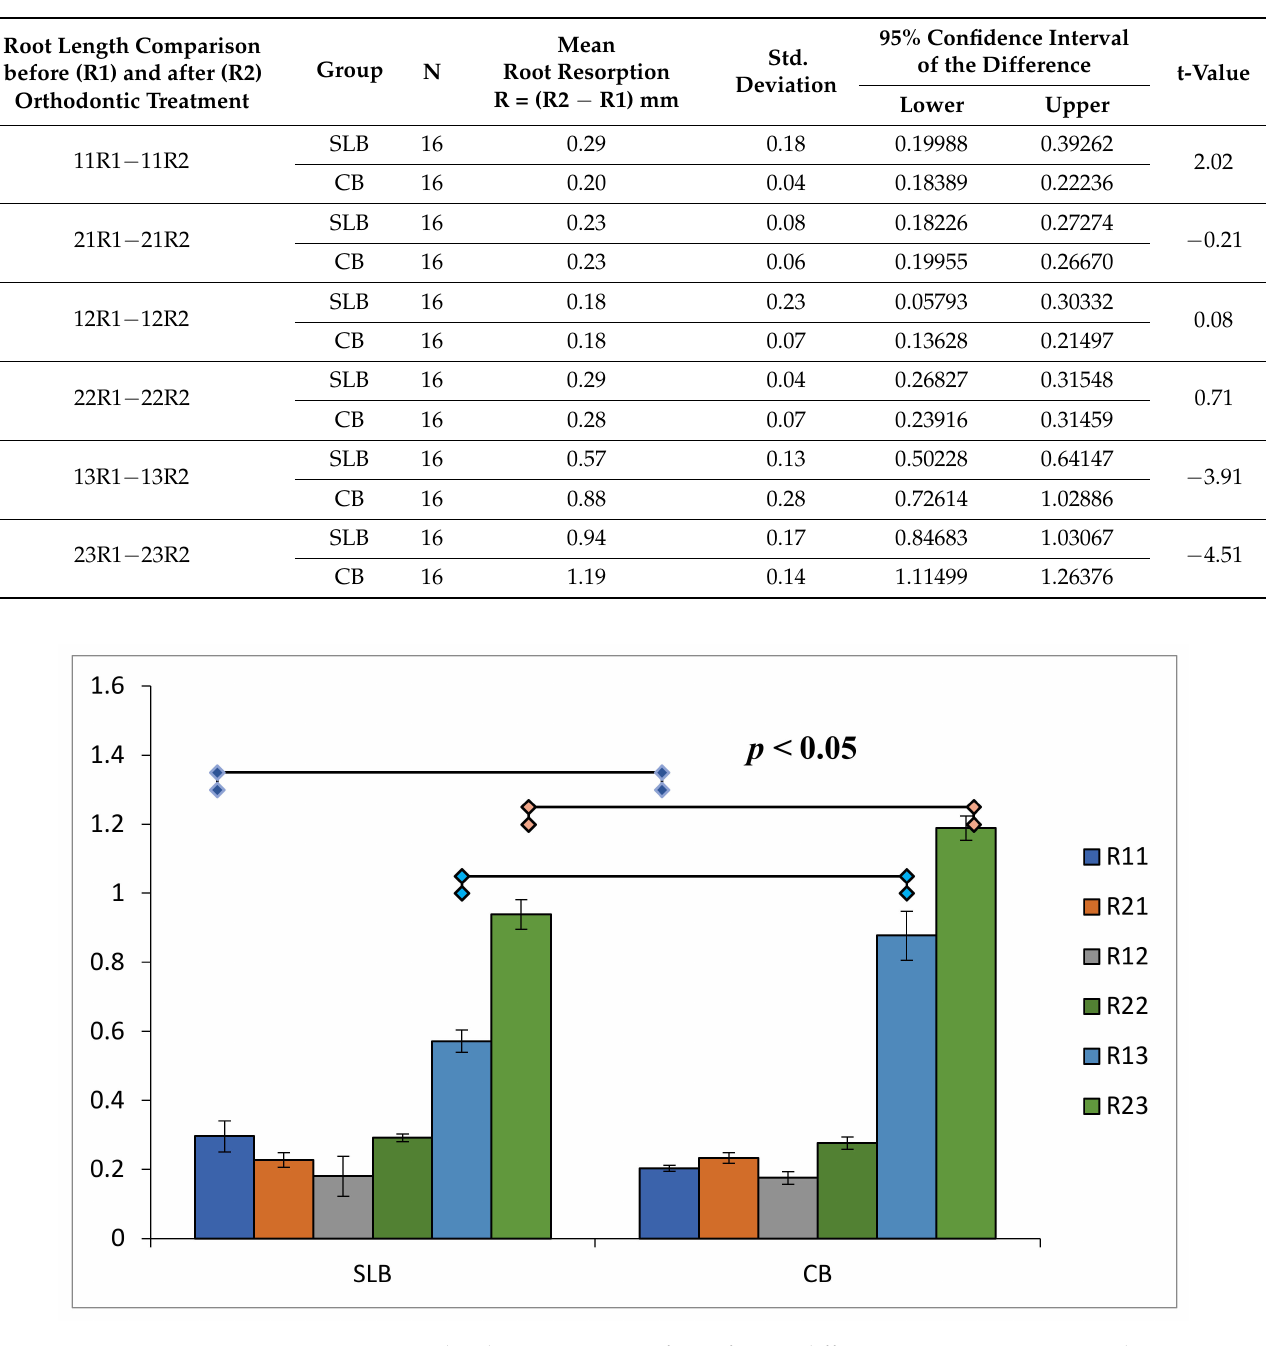
Figure 3. Graphical representation of significance difference in root resorption within intra-group comparison of SLB and